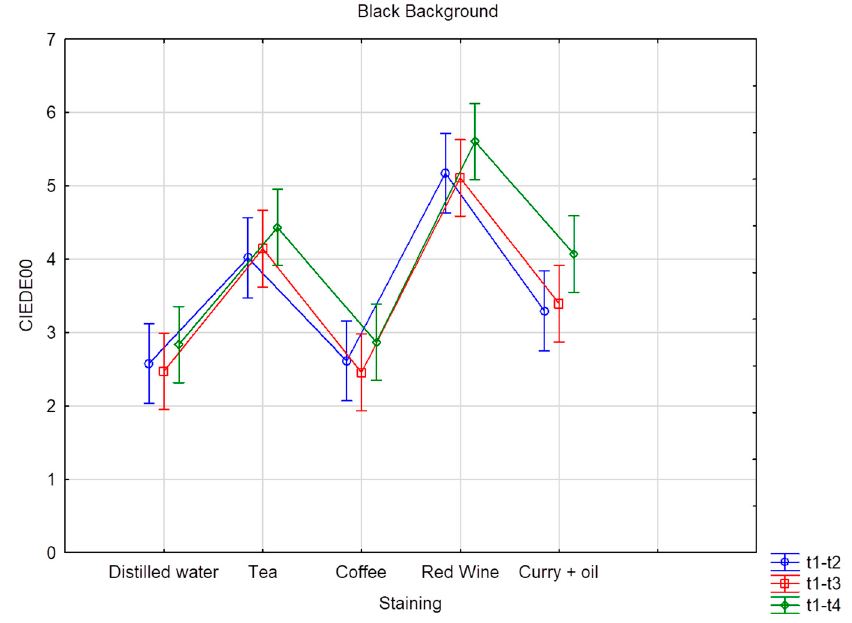
Figure 2. Average color difference in terms of CIEDE00 over time according to different staining liquids analyzed over a black background. Vertical bars denote 95% confidence intervals. Table 8. Mean and Standard Deviations of CIEDE00 color differences (t0-t1) according to different staining liquids analyzed over a white and a black background. ABCDE rankings are from the highest ( A ) to the lowest staining results using Fisher’s LSD post hoc test at a p -value < 0.01.